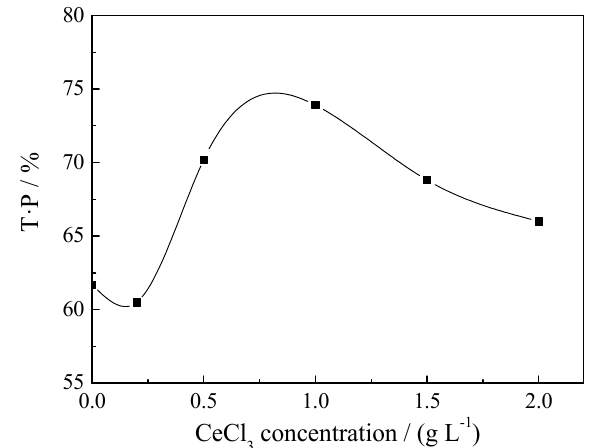
Figure 6. The variation of throwing power (T.P.) values of the plating solutions with CeCl 3 concentrations.